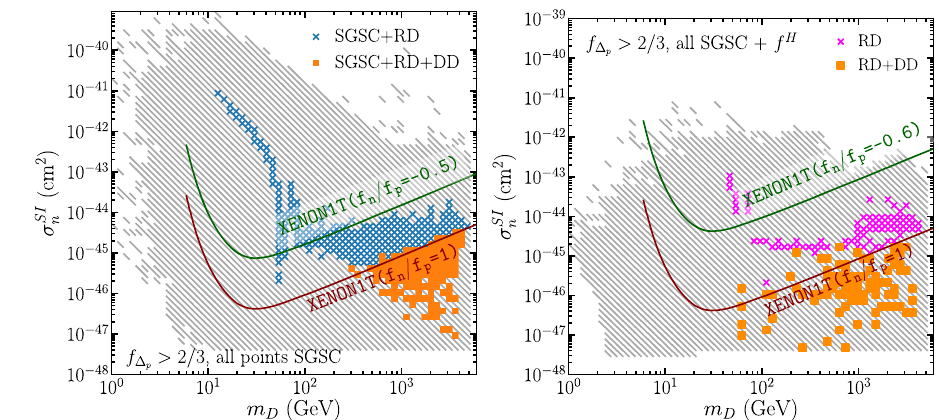
describes the same limit with ISV value f n / f p = − 0 .